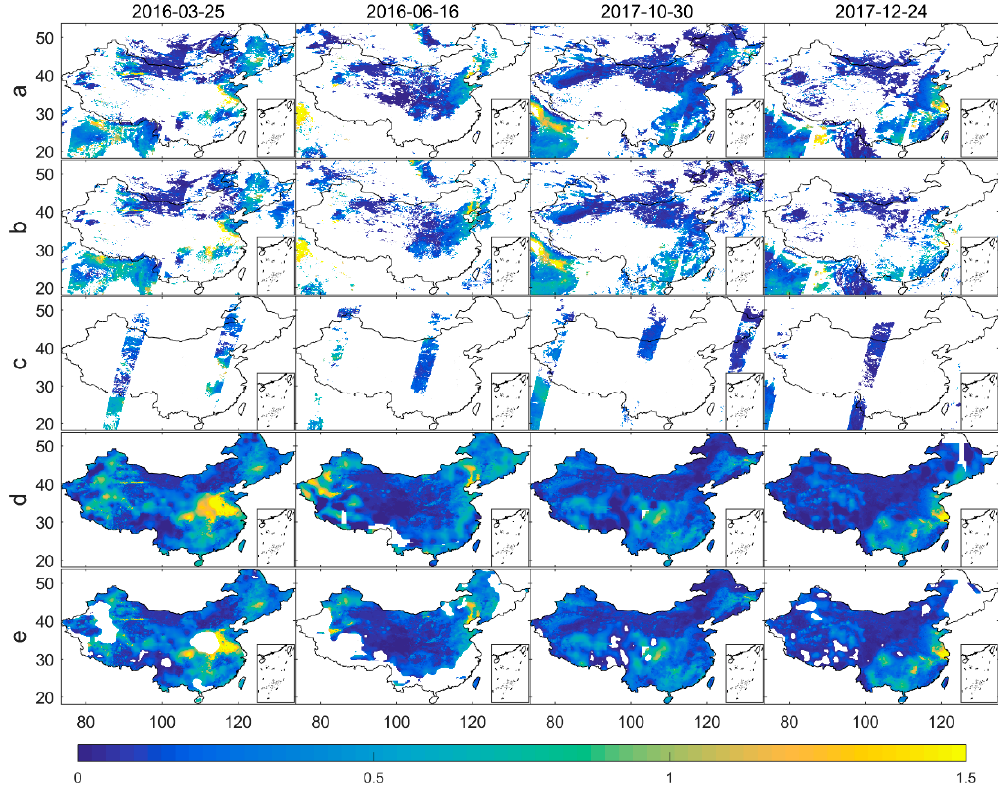
Figure 6. Spatial distributions of ( a ) DB AOD, ( b ) DT_DB_Combined AOD, ( c ) MISR AOD, ( d ) initial FRS fused AOD, ( e ) FRS-EE fused AOD in 25 March 2016, 16 June 2016, 30 October 2017, and 24 December 2017 from four seasons during 2016 and 2017, respectively.